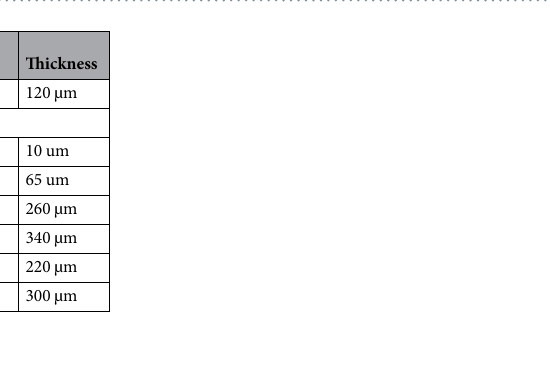
Figure 12. SEM images of surface and cross section of a coating layer ( A,B , respectively), fibrous layer surface ( C ) and surface of a single fiber ( D ).